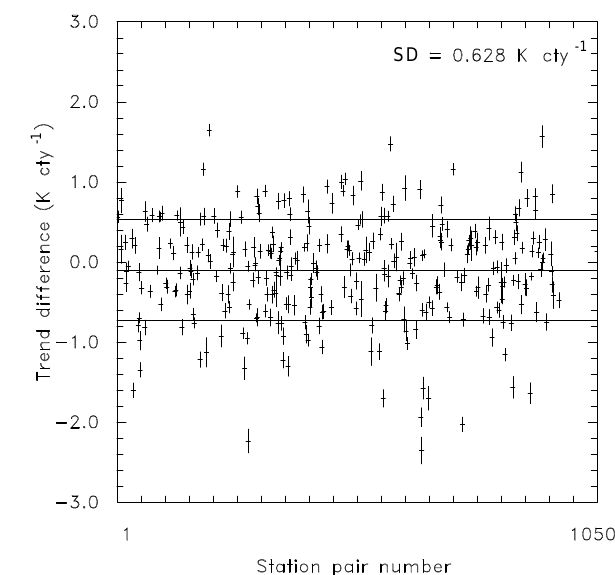
Figure 2. Trends for the difference time series of 316 station pairs (from 1050 stations) in Germany. The standard deviation is 0.628K per century, much higher than expected for homogenous indepen- dent data (short vertical